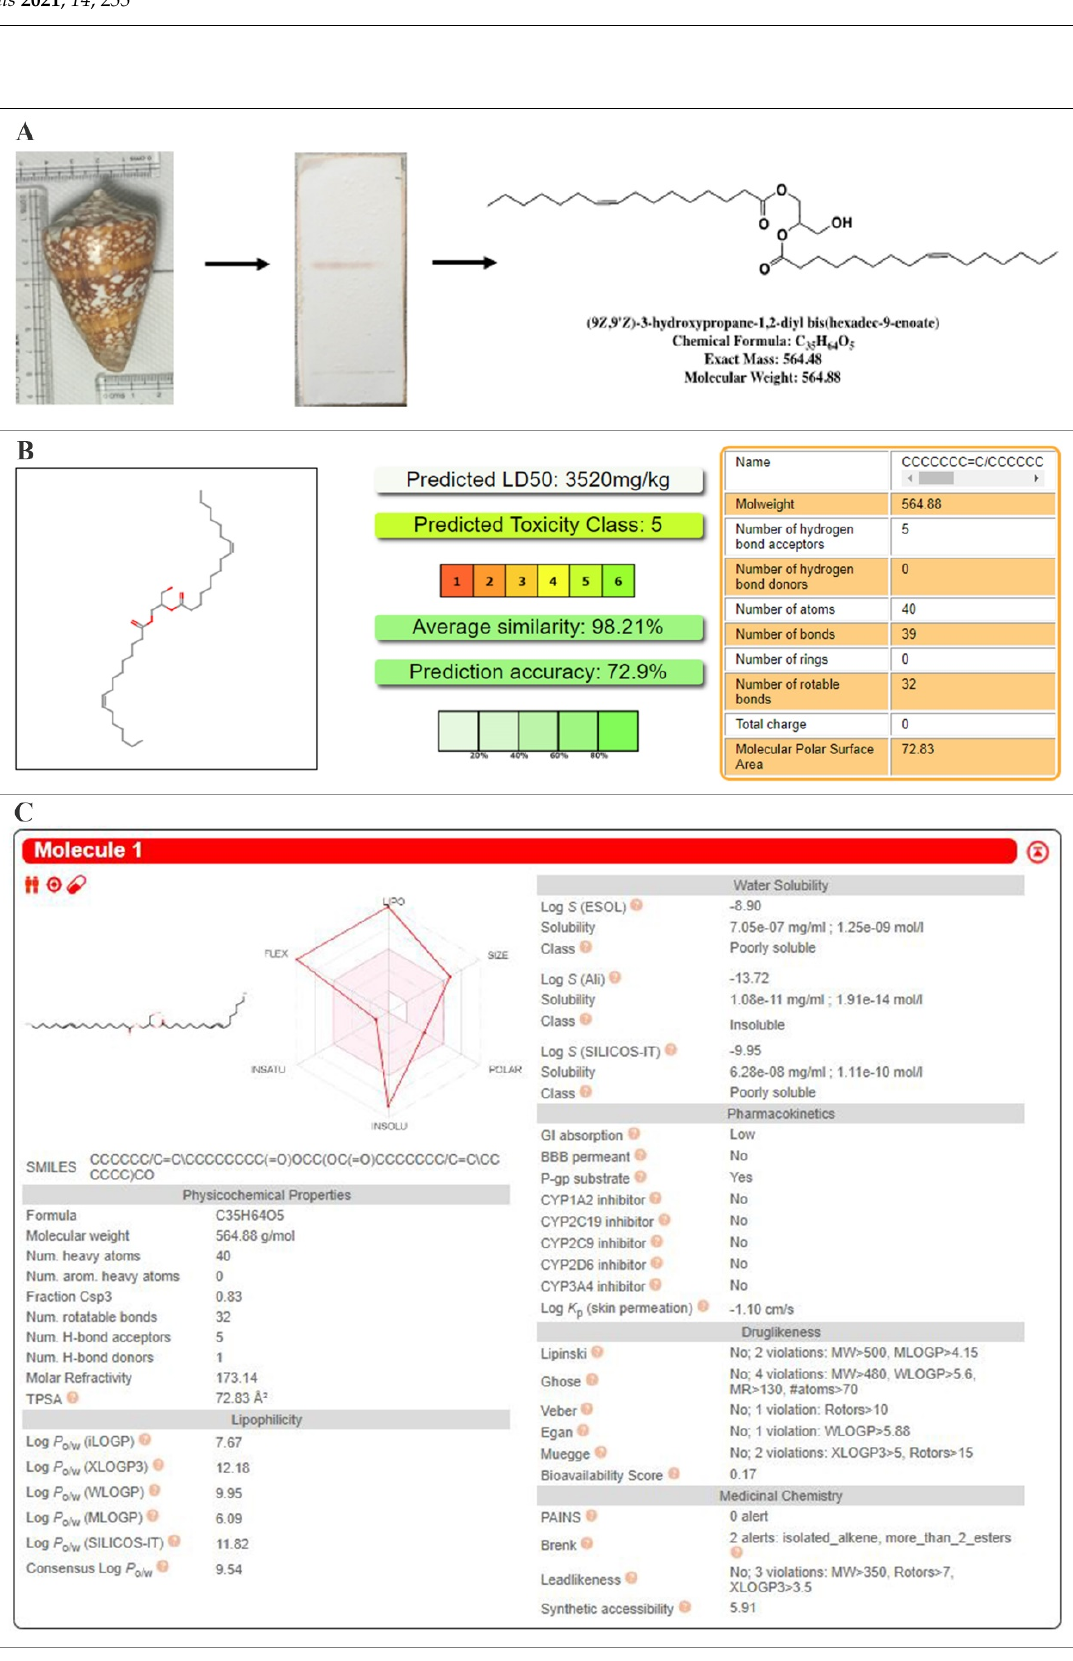
Figure 1. Conus inscriptus shell (left), Thin Layer Chromatogram (TLC) of the active compound (hexane: dichloromethane: 50:50 v/v ; R f -0.5) (middle) and the structure of C2 with molecular details (right) ( A ), Oral toxicity predictions—PROTOX ( B ) and physicochemical and pharmacokinetic properties—SwissADME ( C ).